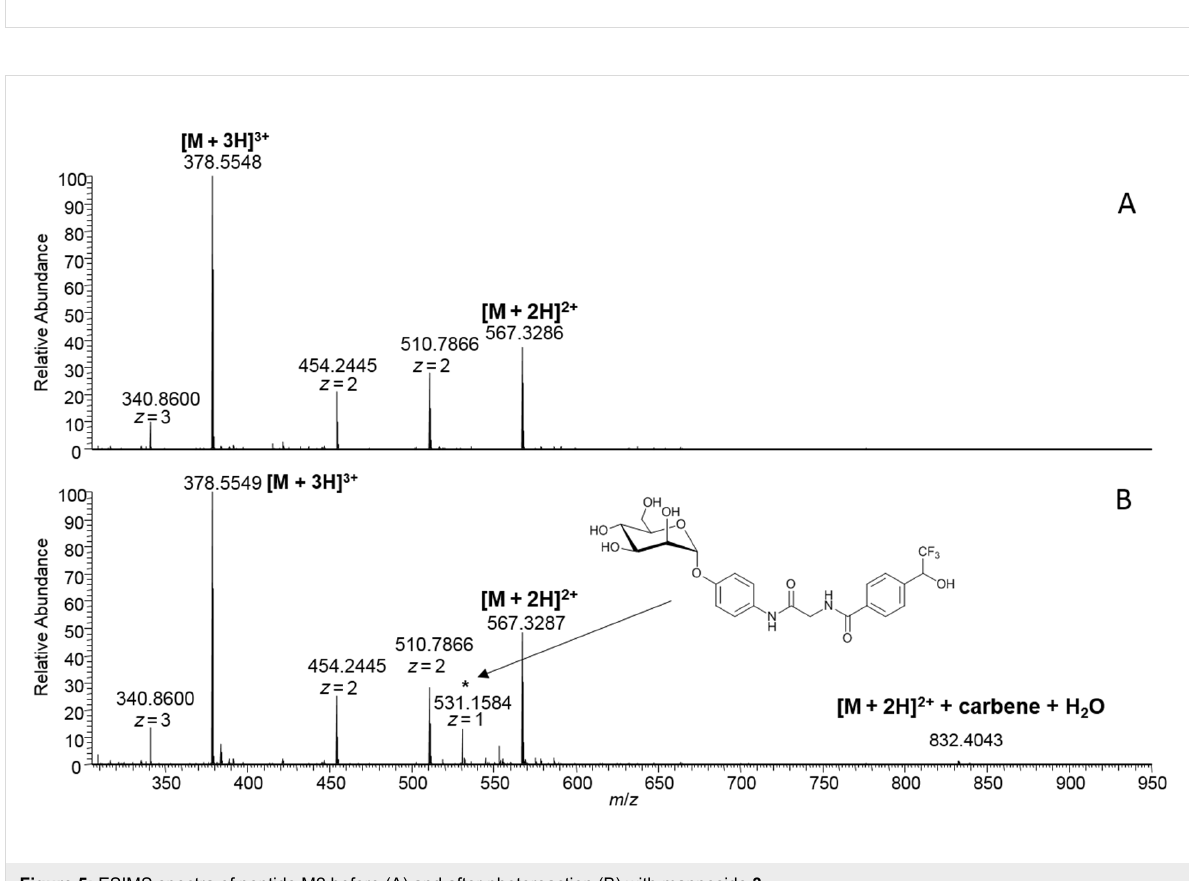
Figure 5: ESIMS spectra of peptide M2 before (A) and after photoreaction (B) with mannoside 3